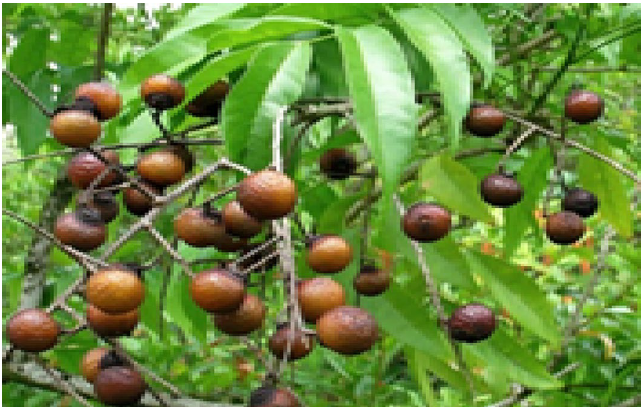
Figure 1. Soapberry.